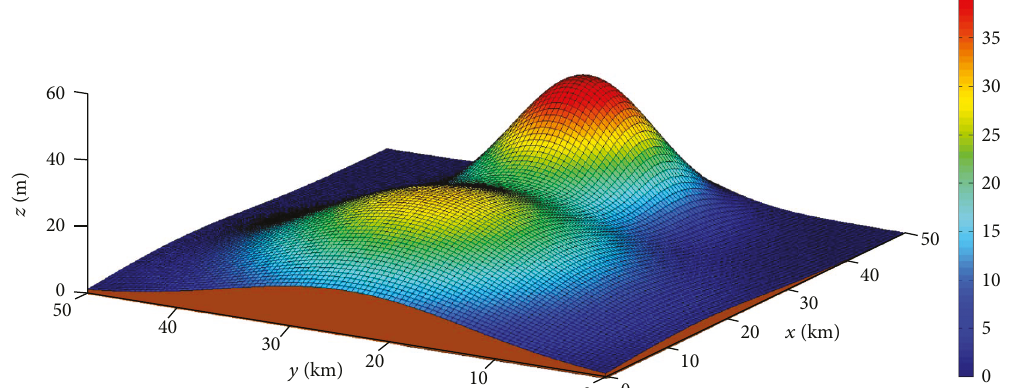
Figure 3: The 3D digital map of the Gaussian terrain model.